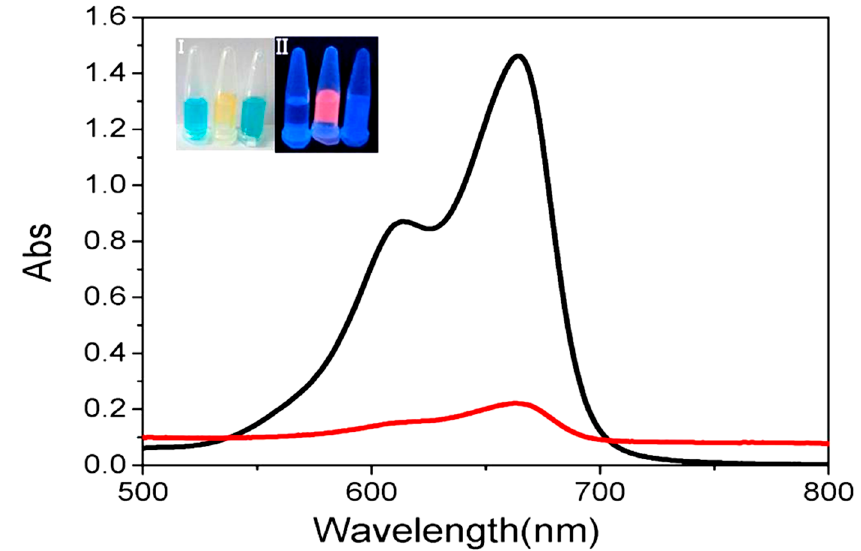
Figure 8. UV-vis spectra of MB solution in the absence (black line) and presence (red line) of monolithic Cu NCs@ESM reacting for 2 min. Inset: photos of MB solution (right), MB solution + Cu NCs@ESM (medium), and MB solution + ESM control (right) under room light (I) and 365 nm UV light (II).